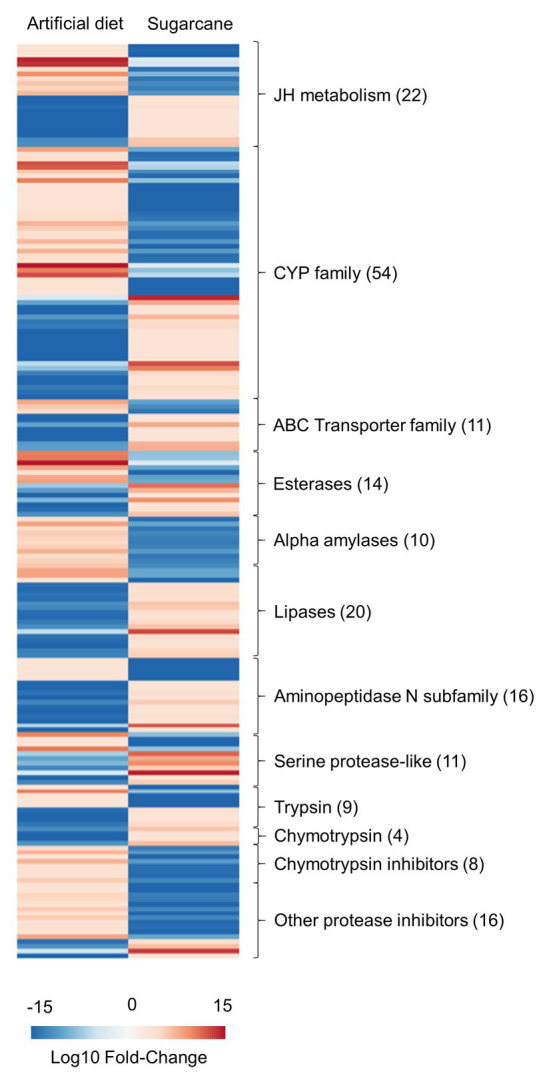
Heatmap showing the expression profile of transcripts clustered into functional groups from highlighted physiological processes. The number within parentheses represents the number of DEGs. Statistical cutoff correspond to a false discovery rate (FDR) less than 0.01 and a Log2 (Fold change) > 2. Fold-change is based on fragments per kilobase per million of reads (FPKM) values.